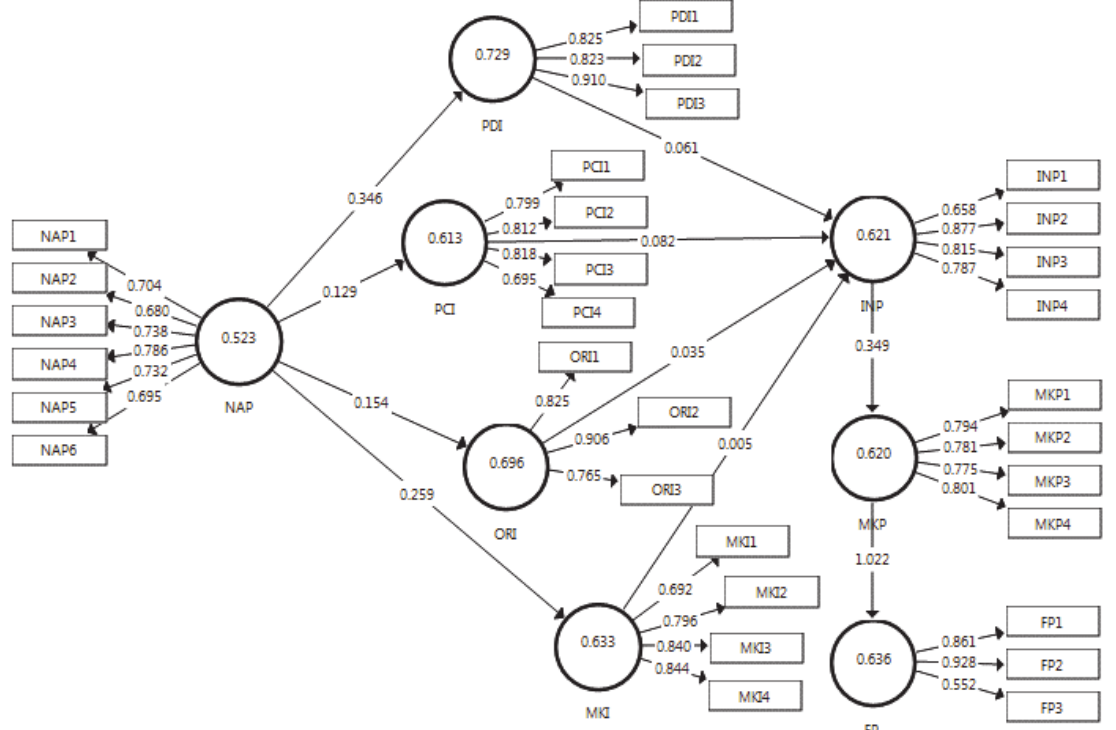
Fig. 3. PLS algorithm